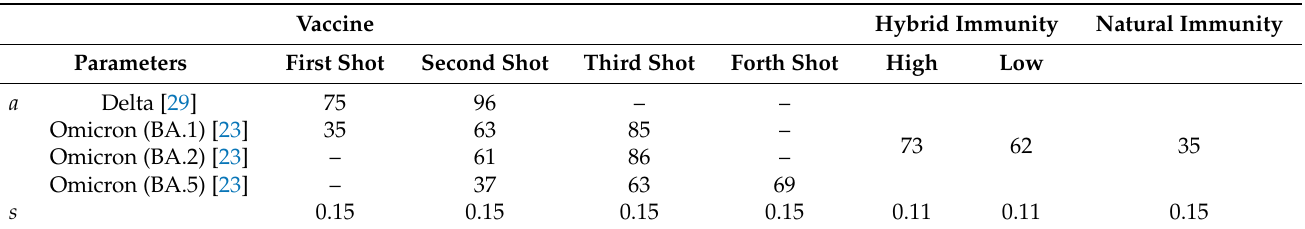
Table 1. Parameters for the individual VE used in Equation